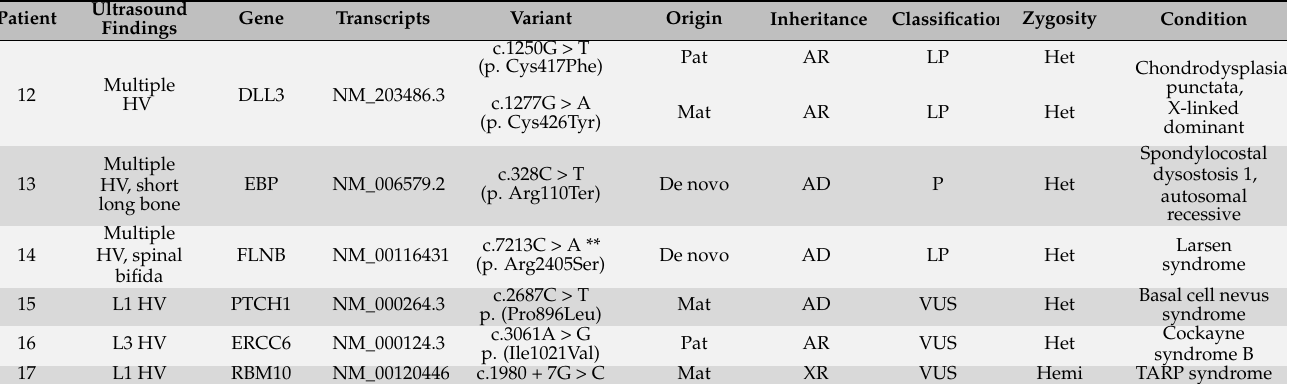
Table 4. Diagnostic variants detected by whole exome sequence in fetuses with